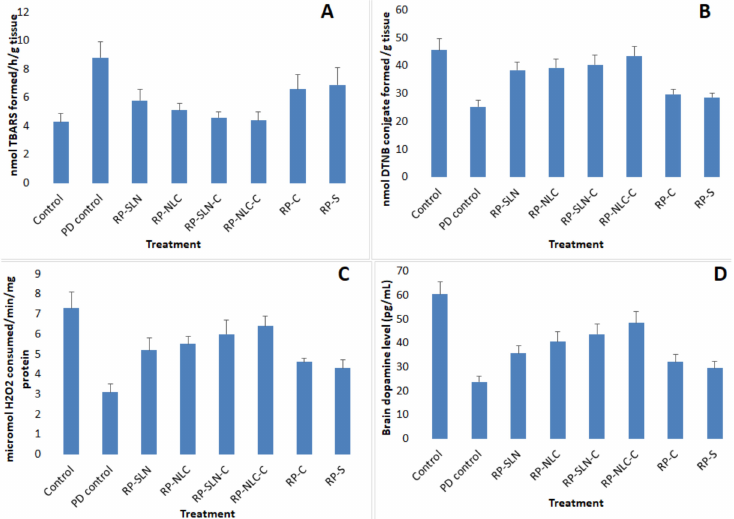
Figure 7. E ff ect of RP loaded lipid nanoparticles, hydrogel formulations and control formulations on ( A ) thiobarbituric acid reactive substances, ( B ) GSH, ( C ) catalase activity and ( D ) dopamine levels in haloperidol induced Parkinson disease rats (mean ± SD, n =